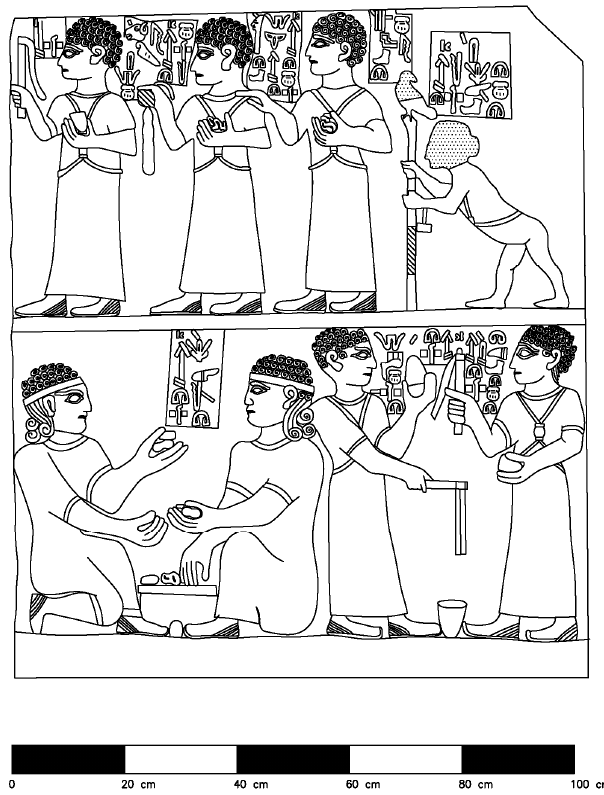
Figure 8. Royal Buttress, Slab B7b. Bottom left: Kamani(?) and Sikara, represented as teenagers, throwing astragali on a board; bottom right: Halpawari and Yahilatispa, represented as young boys, setting whipping tops in motion; upper left: princes Malitispa, Astitarhunza, and Tarnitispa, represented as young boys, holding a whipping top and sets of knucklebones; upper right: prince Isikaritispa, represented as toddler, clenching a staff with a perched bird of prey (drawing by Elia